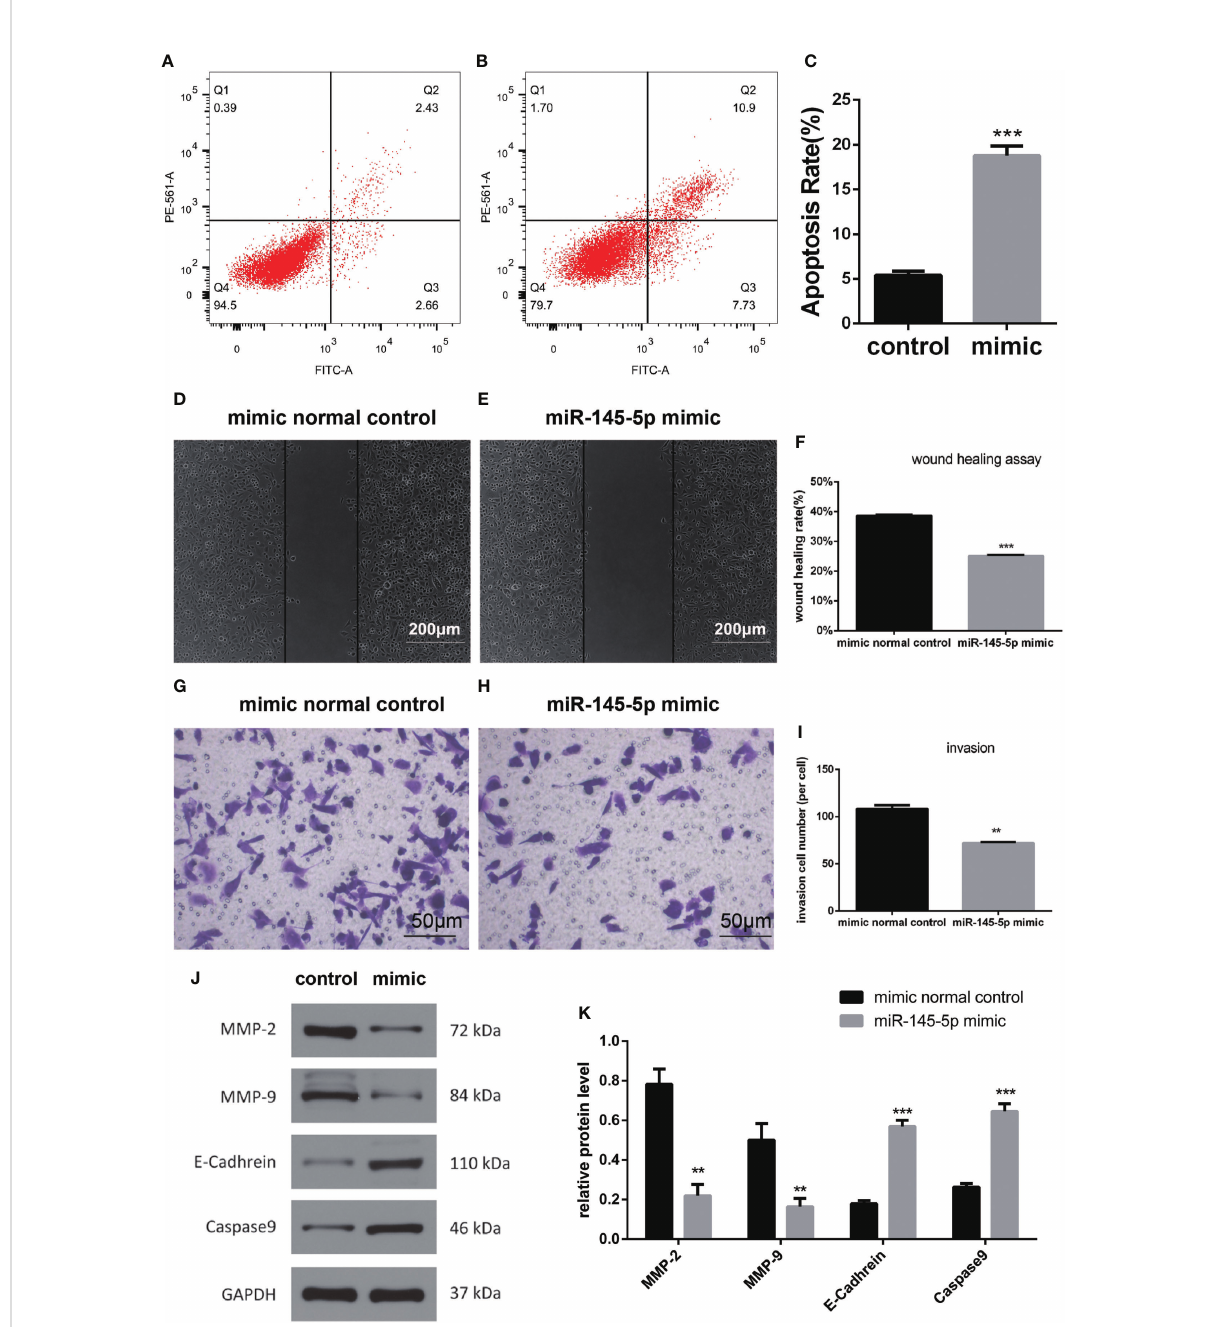
FIGURE 4 miRNA-145-5p affected the EMT to inhibit invasion and migration in bone metastatic Pca cells. (A, B) Flow cytometry cell apoptosis analysis of PC3 cells. Cells are distributed differently throughout the four quadrants of the plot depending on the degree of apoptosis undergone by cell population. Apoptotic cells appear in the greatest concentration in quadrant, Q2. The percentage of cells in Q2 relative to the total population of cells is shown in (C) . (D – F) Scratch tests of PC3 cell migration following miRNA-145-5p mimic transfection. (mean ± SEM, n = 3, Student ’ s t- test). (G – I ) Transwell results of PC3 cell invasions after miRNA-145-5p mimic transfection. (J, K) Caspase 9, E-cadherin, MMP-2 and MMP-9 protein expression in PC3 cell line after miRNA-145-5p mimic transfection. ** P < 0.01, *** P <